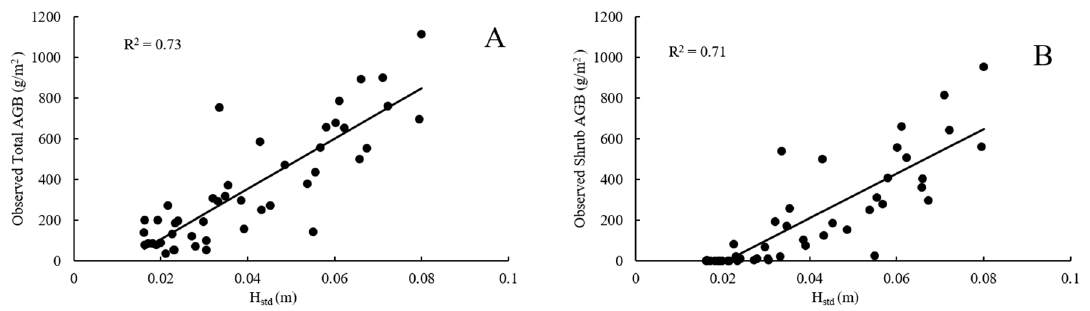
Figure 8. Linear regression of observed total AGB ( A ) and shrub AGB ( B ) with standard deviation of heights (H std ).